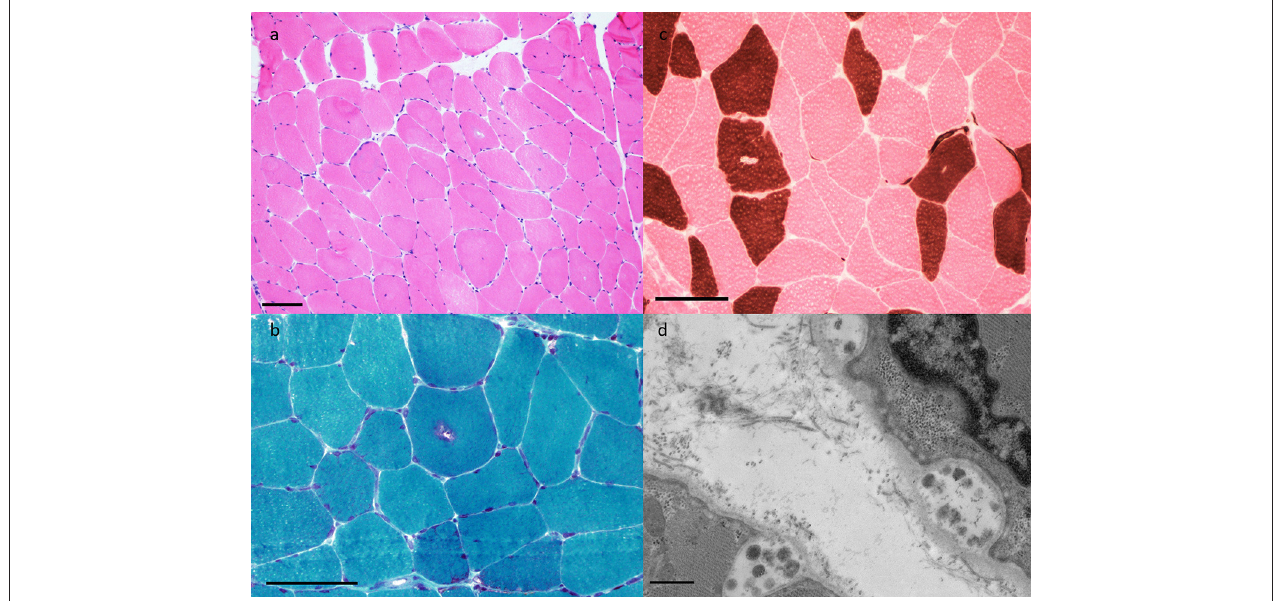
FIGURE 3 | Muscle pathology findings in Case 2. (a) H&E-frozen (40X) showing rare rimmed vacuoles and increased internal nucleation, (b) Gomori trichrome (100X) highlights granular material of the typical rimmed vacuole, (c) ATPase pH4.3 (100X) shows vacuoles to have a predilection for Type I fibers, and (d) Electron microscopy (10,000X) demonstrates autophagic vacuoles.